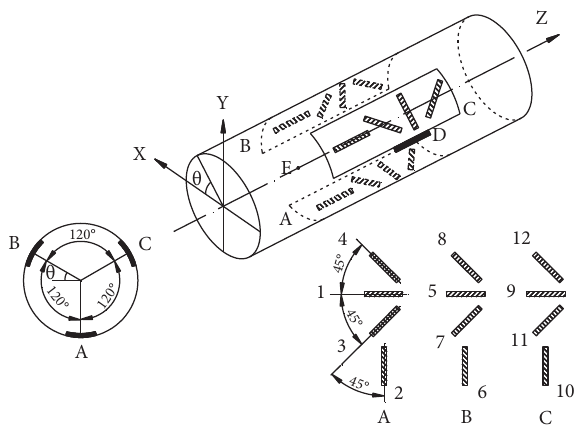
Figure 3: Structure diagram of the hollow inclusion strain gauge with complete temperature